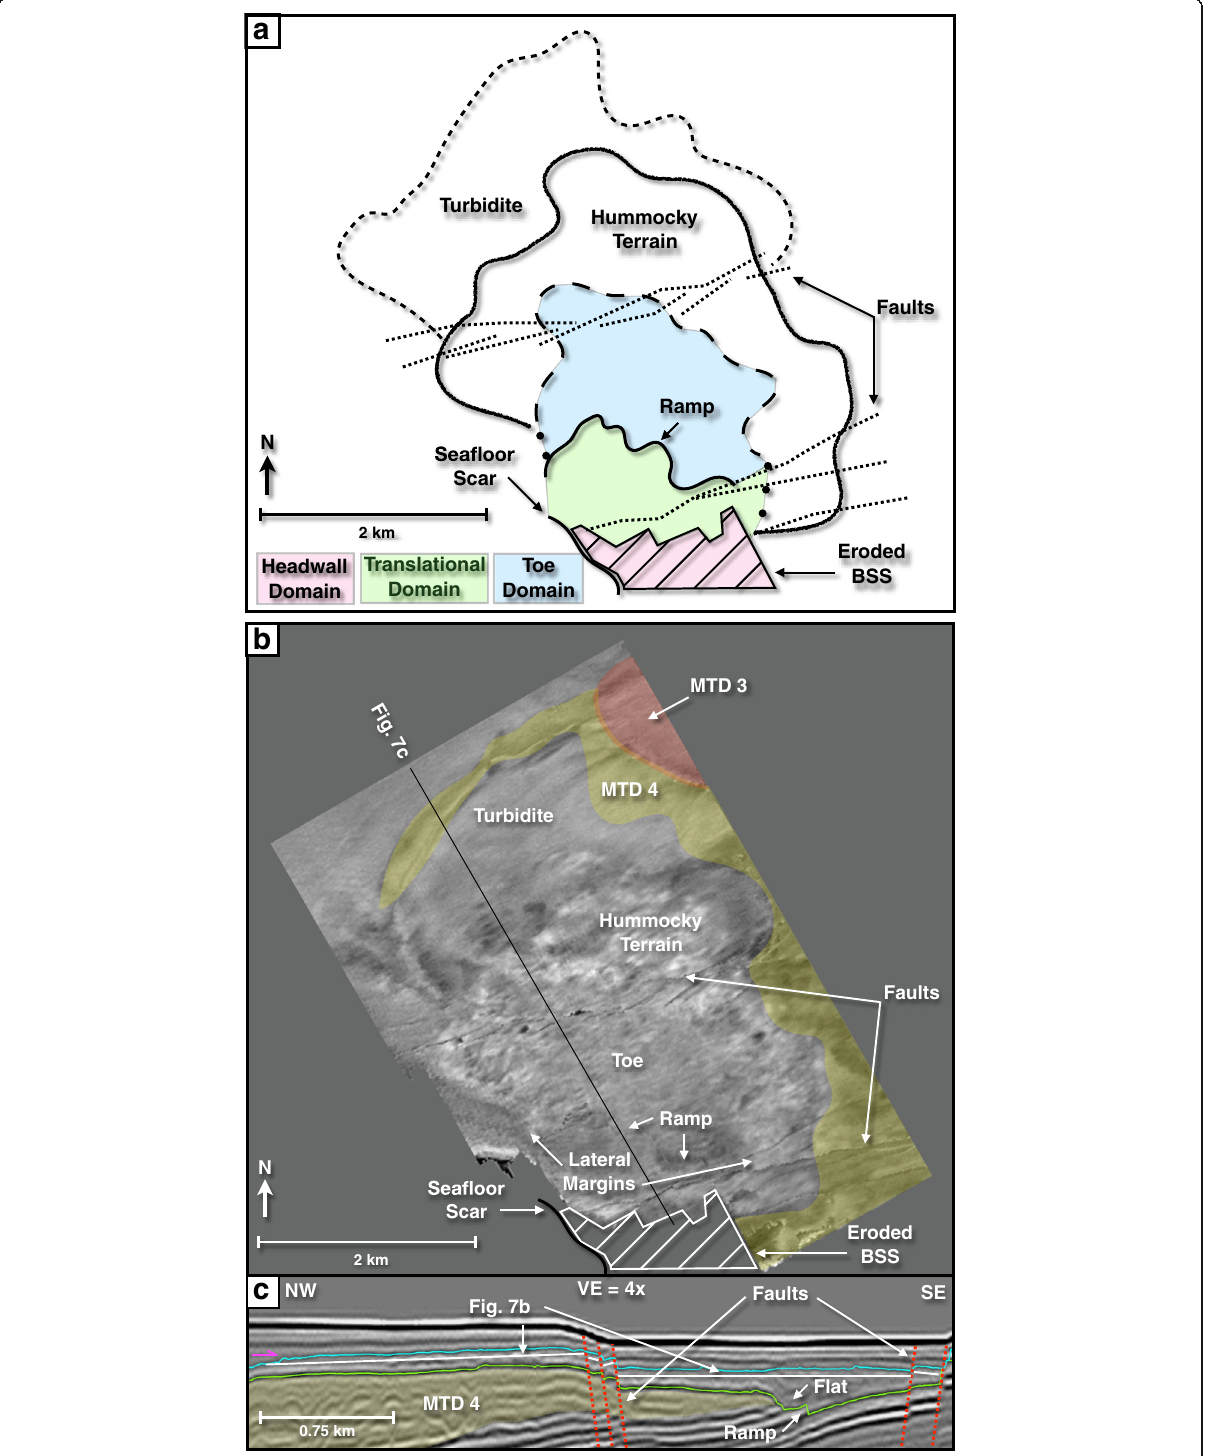
Fig. 7 MTD 6 interpretations. The primary direction of translation is S ➔ N. BSS — basal shear surface. a Schematic depiction of the domains and main kinematic features within MTD 6. Distribution of hummocky terrain and a turbidite are also identified. b Structurally flattened amplitude slice through MTD 6. Inline seismic cross section 2352 transecting the translational and toe domains of the MTD. Location shown in b . c Inline seismic cross section 2352 transecting all three domains (location shown in Fig 7b). Note the hummocky reflections in the NW half of the cross